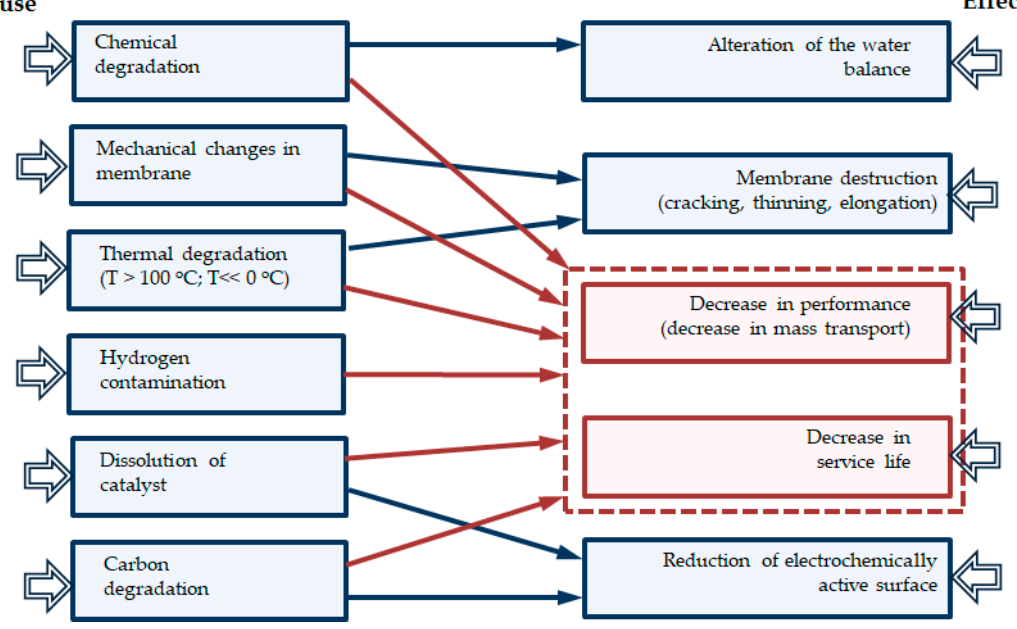
Figure 4. Causes and effects of fuel cell degradation.